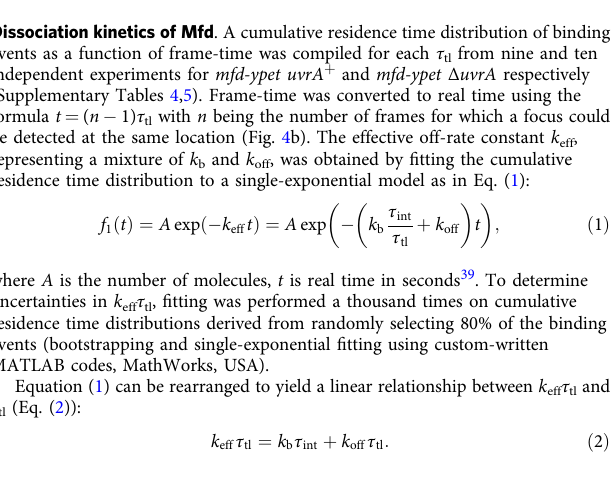
where A is the number of molecules, t is real time in seconds 39 . To determine uncertainties in k eff τ tl , fi tting was performed a thousand times on cumulative residence time distributions derived from randomly selecting 80% of the binding events (bootstrapping and single-exponential fi tting using